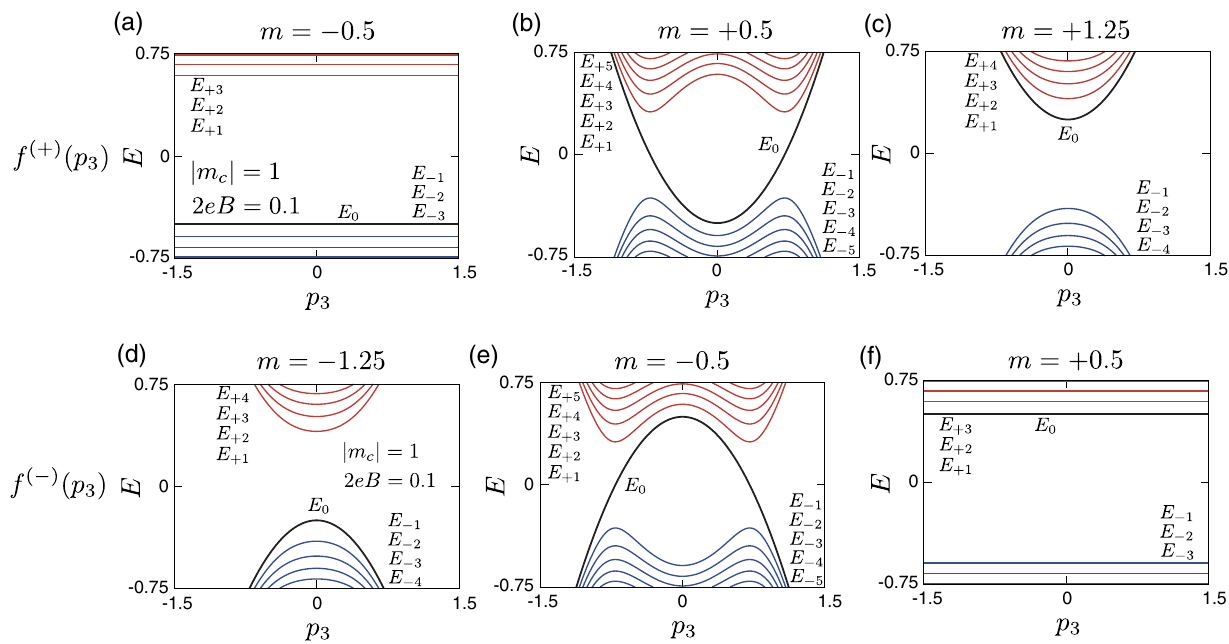
1 and 2 eB ¼ 0 . 1 . The Landau FIG. 4. Landau-level spectra for the 3D Weyl equation (11). Throughout this figure, we choose j m c j ¼ levels with f ðþÞ ð p 3 Þ are shown for (a) m ¼ − 0 . 5 , (b) m ¼ þ 0 . 5 < j m , and (c) m ¼ 1 . 25 > j m . The Landau levels with f ð − Þ ð p 3 Þ are c j c j also illustrated for (d) m ¼ − 1 . 25 < − j m , (e) m ¼ − 0 . 5 > − j m , and (f) m ¼ þ 0 . 5 . The Landau levels E with n > 0 ( n < 0 ) are c j c j n represented by solid red (blue) lines. The zeroth Landau levels E 0 are shown by solid black lines. For m ¼ (cid:2) 0 . 5 , there are remnants of the Weyl nodes around E ¼ 0 : The zeroth Landau levels traverse E ¼ 0 from the valence bands to the conduction bands. The asymmetric nature of the zeroth Landau levels around E ¼ 0 is a manifestation of the chiral